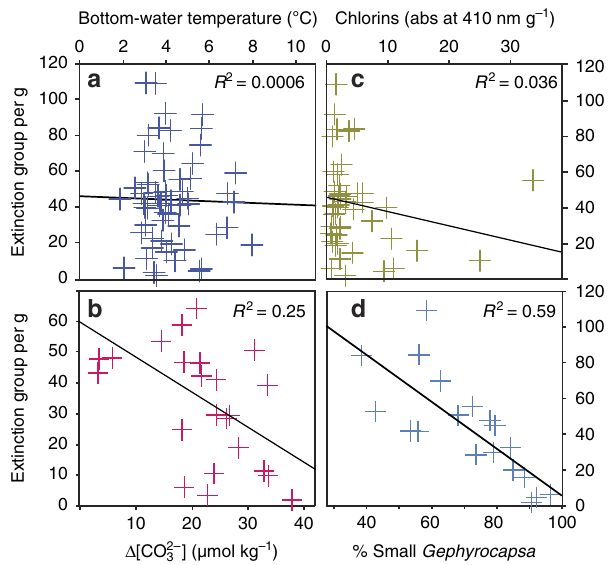
Figure 2 | Foraminiferal extinction group against other parameters for the pre-extinction interval B 0.8–1Ma. ( a ) Bottom-water temperature derived from foraminiferal Mg/Ca, ( b ) bottom-water D [CO 3 2 (cid:2) ] derived from foraminiferal B/Ca, ( c ) chlorin P410 from bulk sediment and ( d ) % small